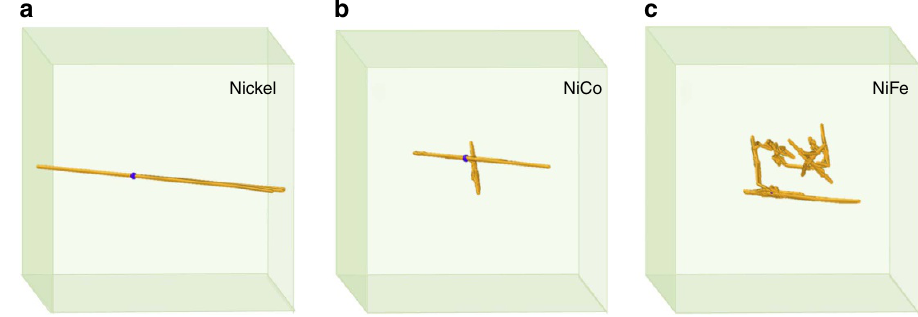
Figure 4 | Trajectories of the centre of a nine-interstitial cluster. ( a ) In nickel at 800K, ( b ) in NiCo at 1,200K and ( c ) in NiFe at 1,200K. The trajectories clearly show the different migration behaviours in these